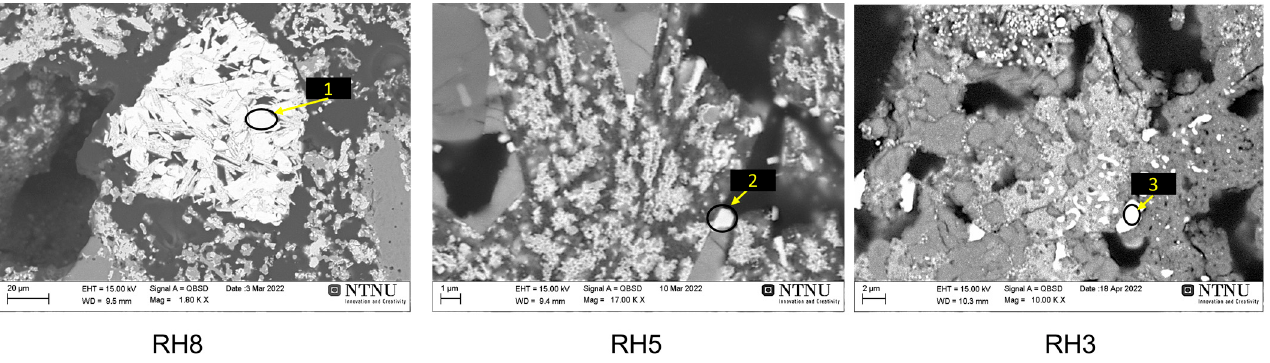
Figure 14. SEM image and EDS analysis of reduced sample RH8.